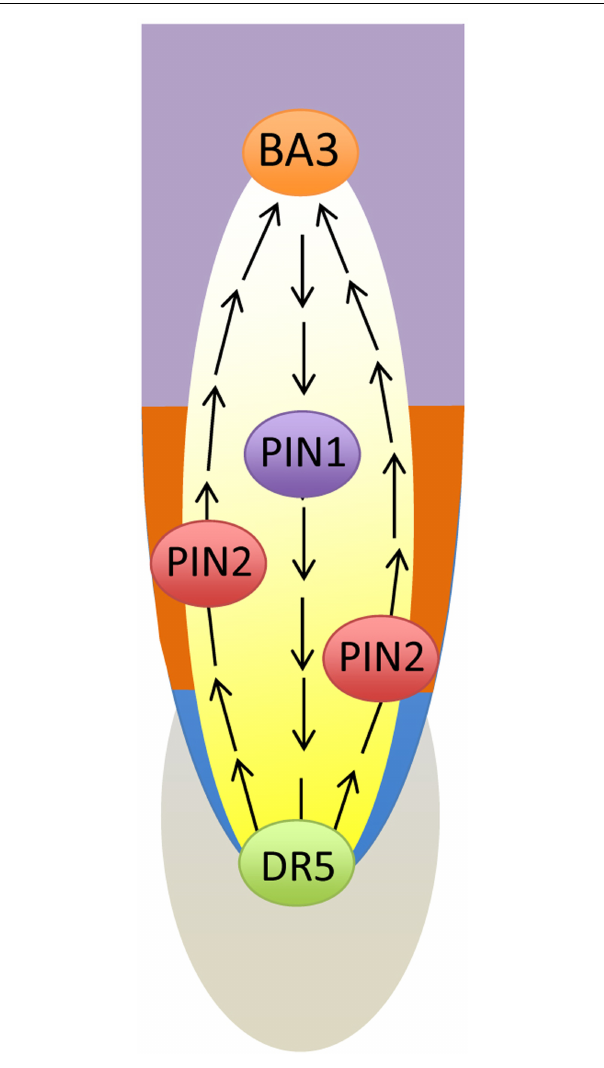
FIGURE 5 | Schematic views of two loops of the polar auxin transport streams at the root apex. In the central stelar tissue, polar auxin transport stream is polarized toward the root cap. Here it is redistributed laterally in a fountain-like manner toward the root periphery at which the stream gets opposite (shootward) polarity and continues up to the basal border of the transition zoner, where it is looping back via an inversed fountain-like manner back to the central stelar tissues.This complex pattern of polar cell–cell transport of auxin is tightly linked with sensory events at the root cap and instruct the motoric events at the apical portion of the elongation region (Baluška etal., 2009a,b, 2010a; Baluška and Mancuso, 2013a).